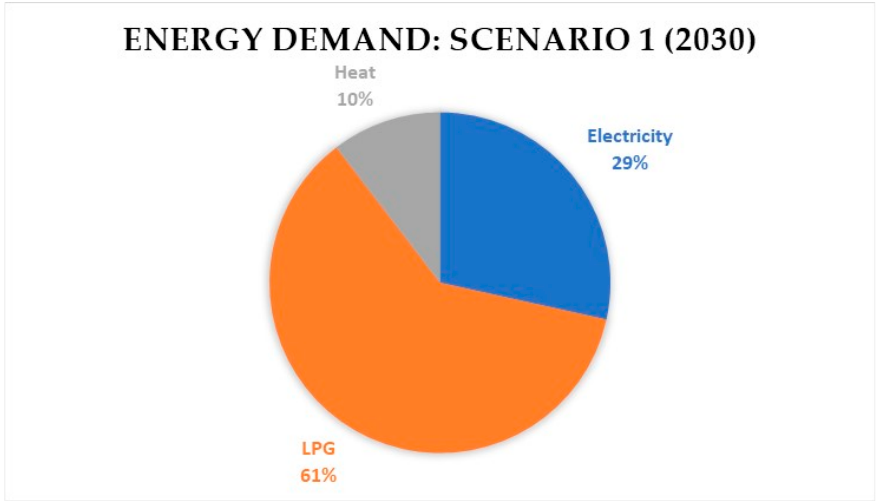
Figure 8. Scenario 2. Energy consumption in 2030, residential sector. Figure 6. Scenario 2. Energy consumption in 2030, residential